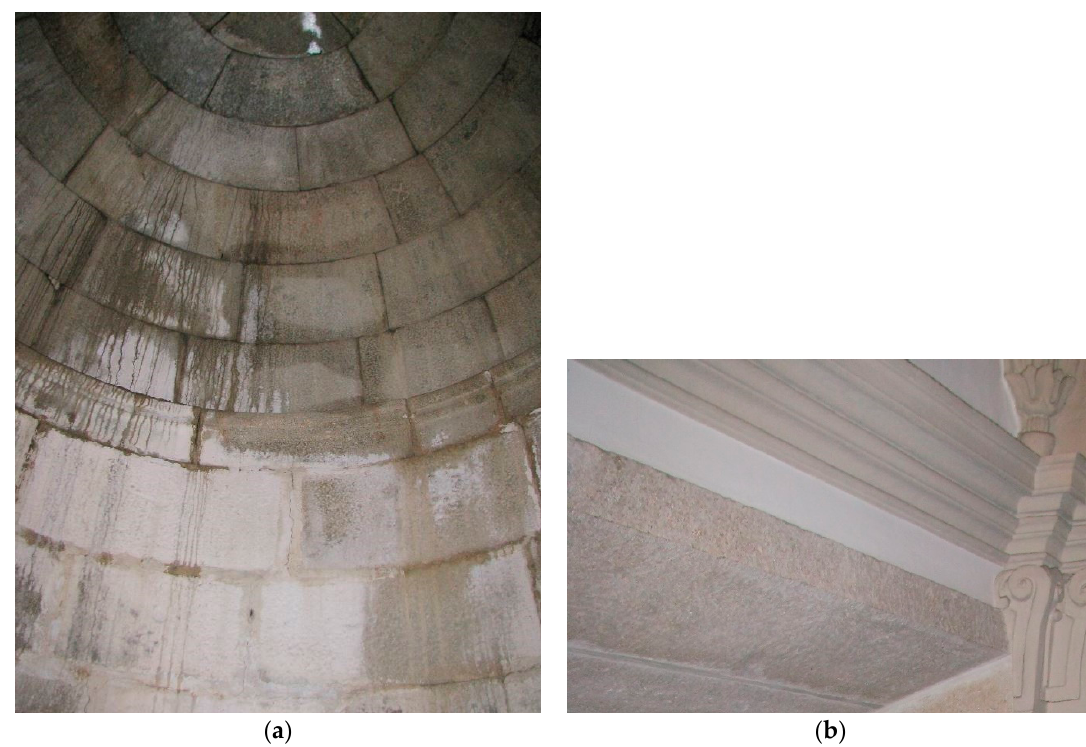
Figure 1. Images illustrative of the indoor space typology: ( a ) type A spaces, where granite is the dominant material in all the space elements (floor, walls, ceiling); ( b ) type C spaces, where there are granite applications but other materials are as abundant as or more abundant than